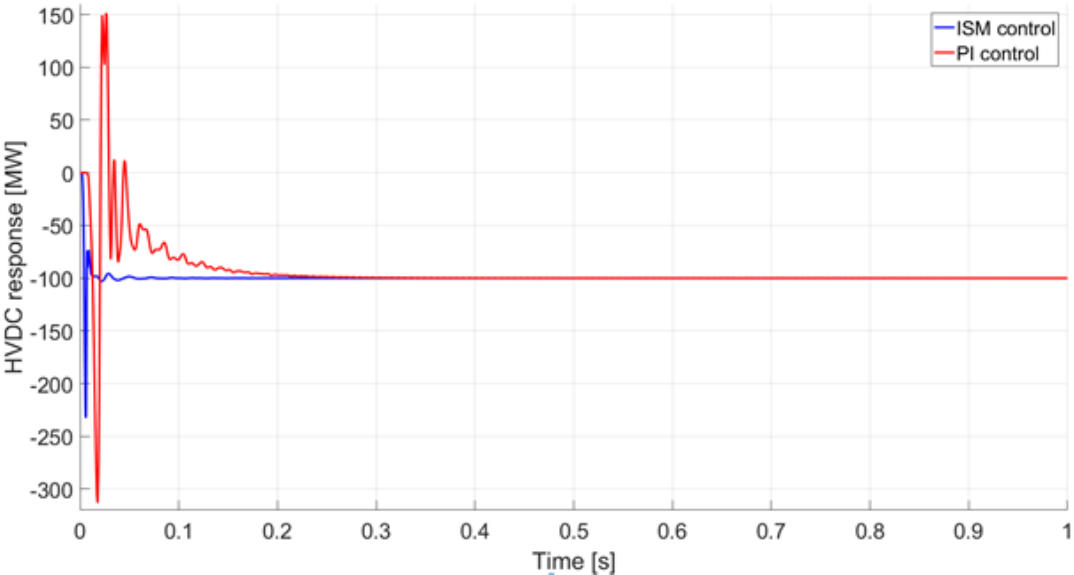
Figure 6. Output active power of HVDC in the case of integral sliding mode controller (ISMC) and PI